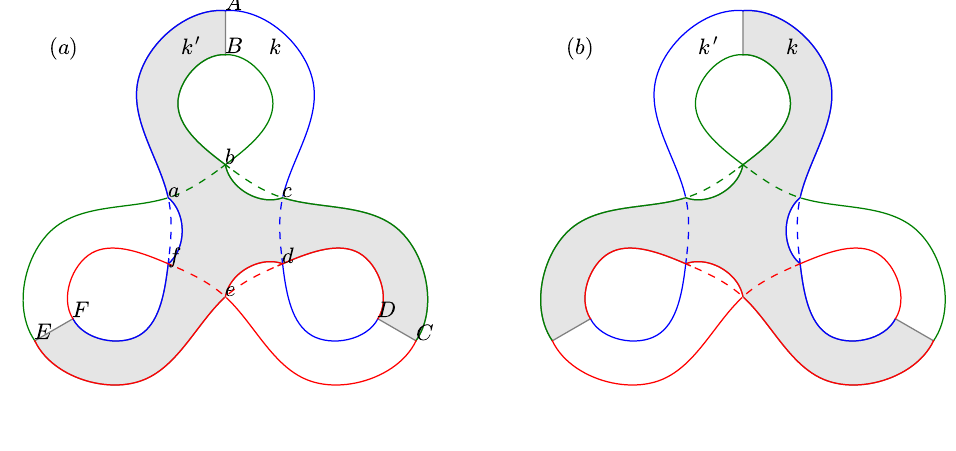
Figure 7: (a) Part of the Konstantinov torus (it is an immersed torus in 3d, here with a disk removed along the free edge): two “hexagonal” sheets k ( ADCF EB ) and k (cid:48) ( ABCDEF ) glued together along AB , CD and EF , giving a sheet k ∪ k (cid:48) with a single edge at z = 0 (the rest of the surface being at z > 0). There are three intersections along the arcs ( a f ) , ( bc ) , and ( ed ) (solid lines), where k crosses under k (cid:48) . (b) The chiral image of (a): k (cid:48) crosses under k . The impossibility to connect these two immersions (a) and (b) by a 2-perfect regular homotopy provides a topological interpretation of the color exchange invariant I (see section 2